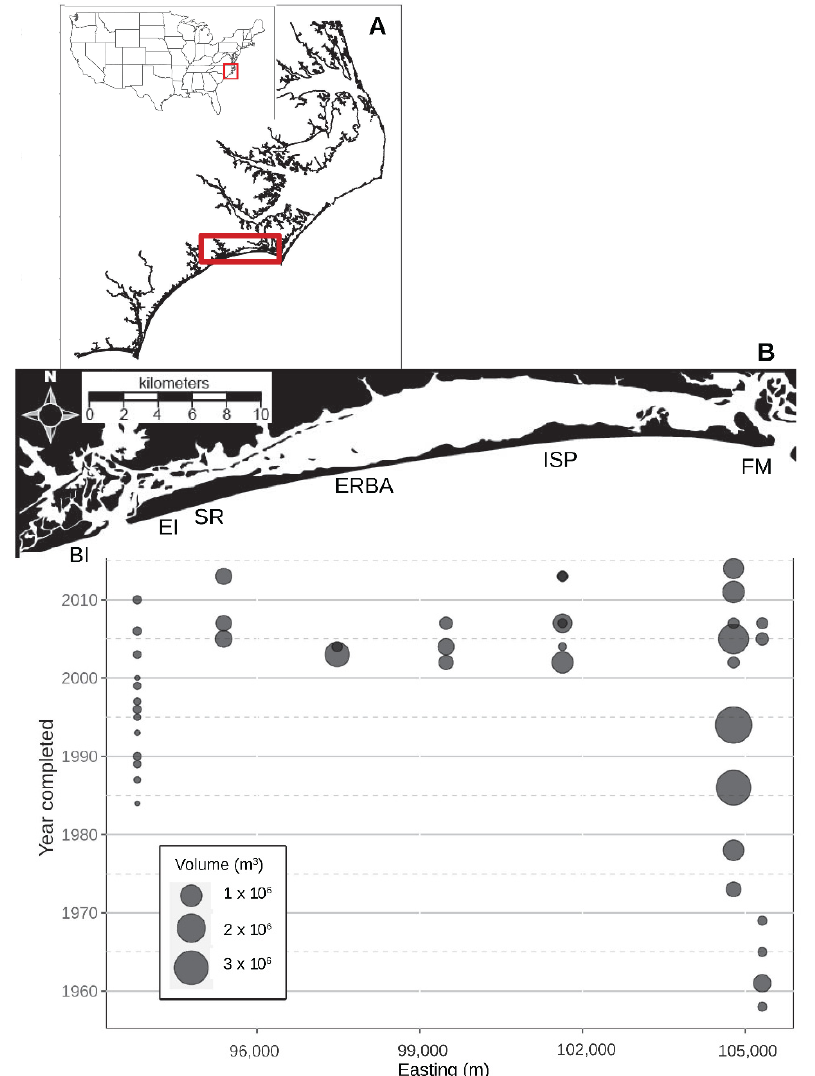
Figure 1. Location of Bogue Banks, North Carolina, USA ( A ) and the nourishment history of the island ( B ). The bubbles on the bubble plot below indicate the approximate midpoint of the spoil area for each recorded nourishment event as well as the approximate volume (m 3 ) of material emplaced. Study beaches referred to in the text: BI—Bear Island; EI—Emerald Isle; SR—Spinnaker’s Reach; ERBA—Eastern Regional Beach Access; ISP—Iron Steamer Pier; and FM—Fort Macon.